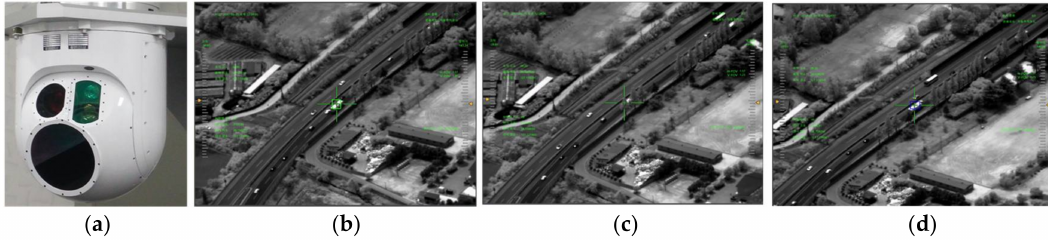
Figure 24. Result of application for airborne EO/IR: ( a ) shape of airborne EO/IR ( b – d ) operational images of testing coast mode